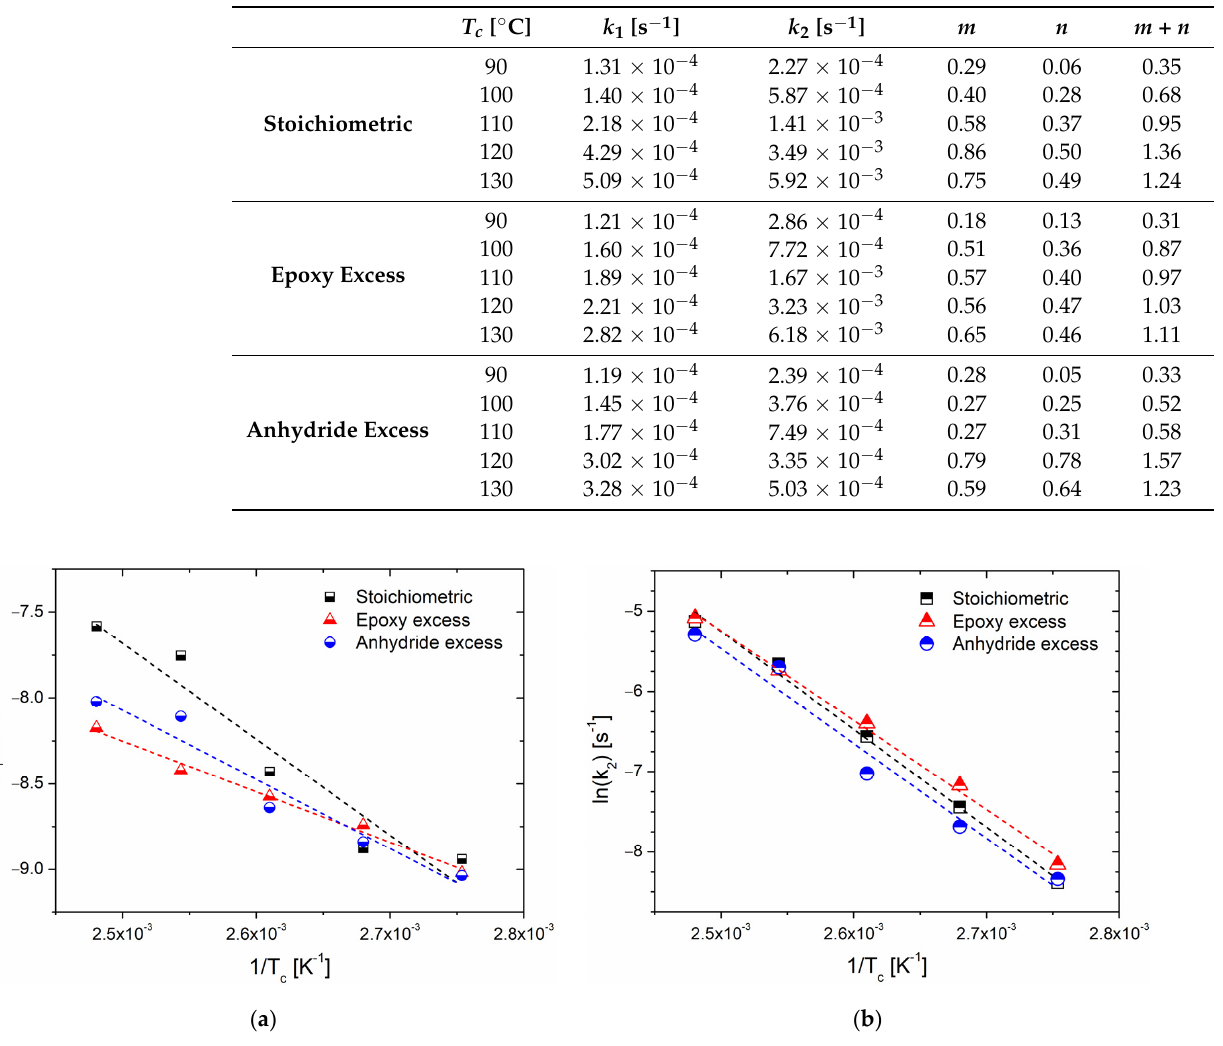
Figure 4. Linear plots of the logarithm of the rate constants, ( a ) ln( k 1 ) and ( b ) ln( k 2 )), obtained by fitting the isothermal data with the Kamal model (Equation (9)) as function of the inverse of the cure temperature (1/ T c ) at different epoxy/anhydride ratios. Table 5. Values of the preexponential factor ( A 1 ) and activation energy ( E a1 ) from the linear fitting of the rate constant k 1 and values of the preexponential factor ( A 2 ) and activation energy ( E a2 ) from the linear fitting of the rate constant k 2 for systems at different epoxy/anhydride ratios.